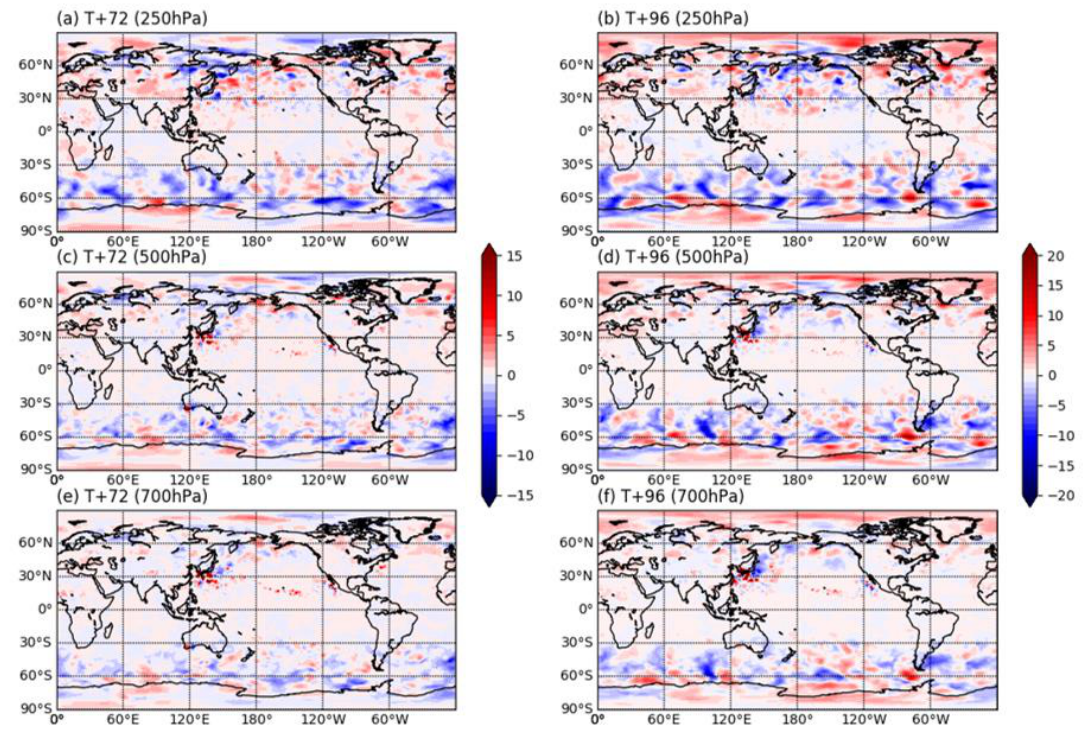
Figure 9. Global map of the mean difference of RMSE of ( a , b ) 250 hPa, ( c , d ) 500 hPa, and ( e , f ) 700 hPa geopotential height at ( a , c , e ) T + 72 and ( b , d , f ) T + 96 forecast hours between the latency_20m run and the control run.